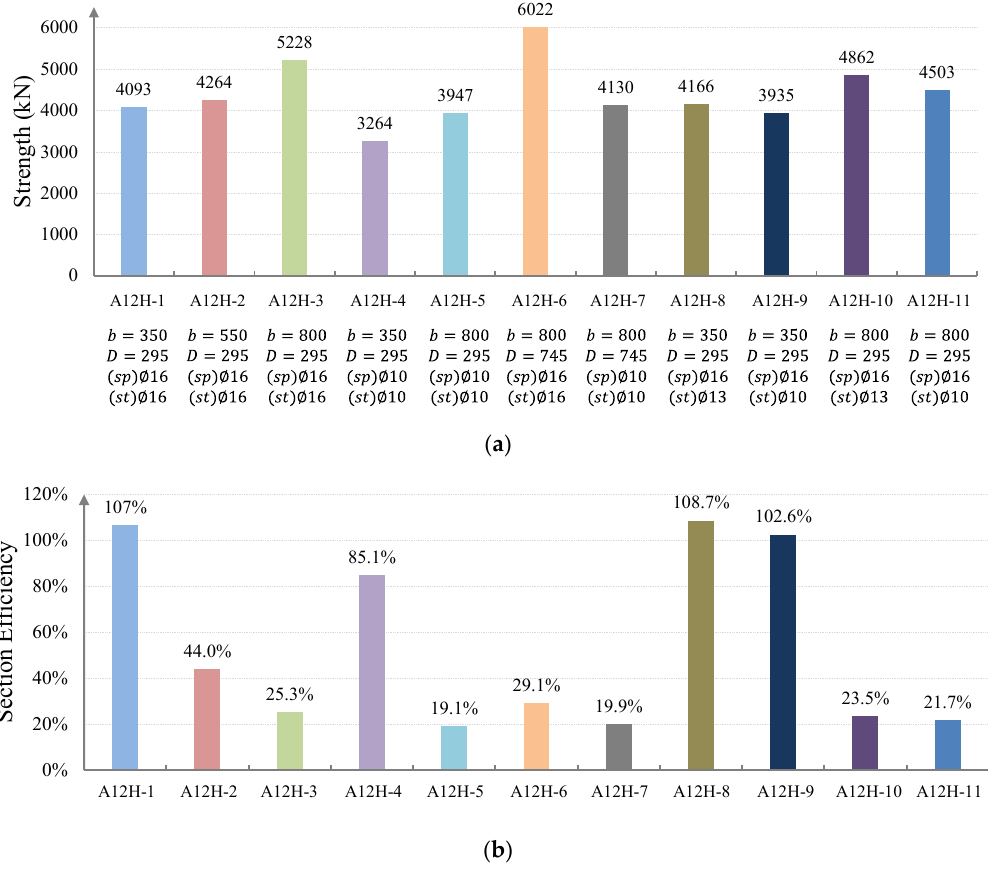
( c ) Figure 5. Test results: ( a ) maximum load; ( b ) load-carrying efficiency (cid:3436) (cid:3017) (cid:3296) (cid:3033) (cid:3278)(cid:3284)(cid:4594) ((cid:3002)(cid:2879)(cid:3002) (cid:3279)(cid:3296)(cid:3278)(cid:3295) ) (cid:3440) ; ( c ) net bearing stress at maximum load ( 𝑃 (cid:3048) /𝐴 (cid:3029) ).